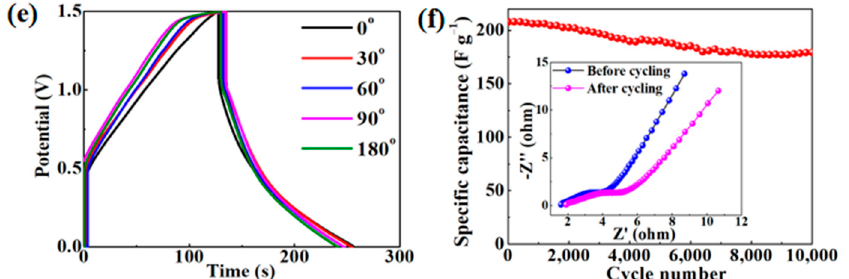
Figure 4. ( a ) CV curves of the flexible asymmetric device, recorded at different scan rates. ( b ) GCD curves of the flexible asymmetric device recorded at different current densities. ( c ) Specific capacitance of the flexible asymmetric device recorded at different current densities. ( d ) GCD curves of the flexible device recorded at a current density of 5 A g − 1 over different potential ranges (0–1.1 V to 0–1.5 V). ( e ) GCD curves of the flexible device with different bending angles at a current density of 5 A g − 1 . ( f ) Cycling performance of the flexible asymmetric device at a current density of 1 A g − 1 and EIS data of the flexible ASC device before and after 10,000 cycles (inset).